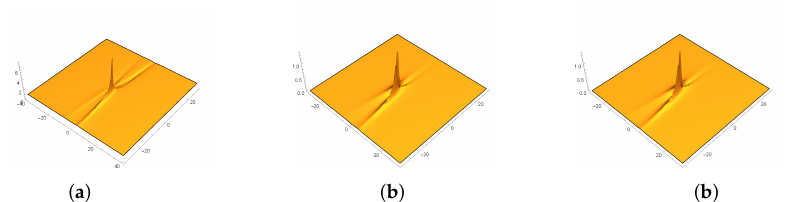
Figure 14. ( a – c ) are the rogue wave solution via Equations (26a)–(26c) with ρ = 1, φ = 0, c 1 ( z ) = √ z 2 + 3 2, c 2 ( z ) = z 2 and γ 1 = 1 + 2 i ,